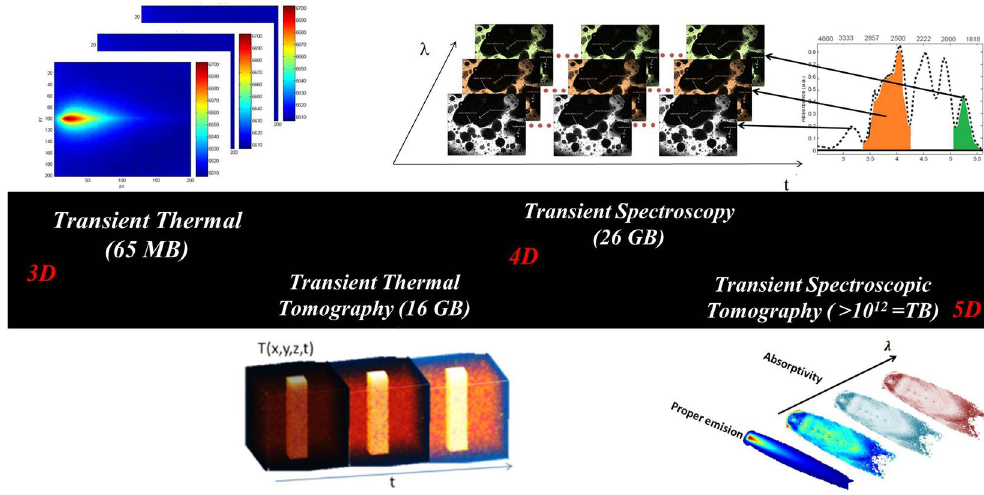
Figure 9. Data generated with IR spectroscopic imaging for different transient diffusion problems. (Created with Powerpoint 2013, www.micro